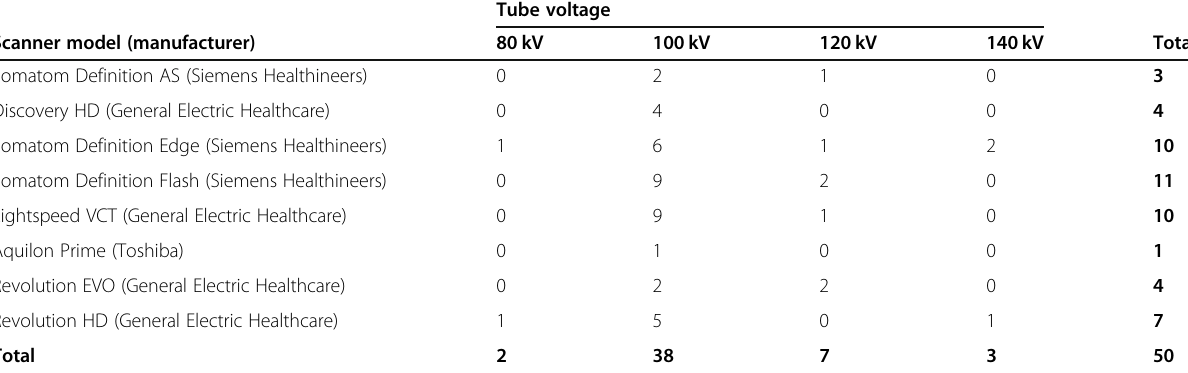
Table 2 Number of patients imaged with each computed tomography scanner and tube voltage